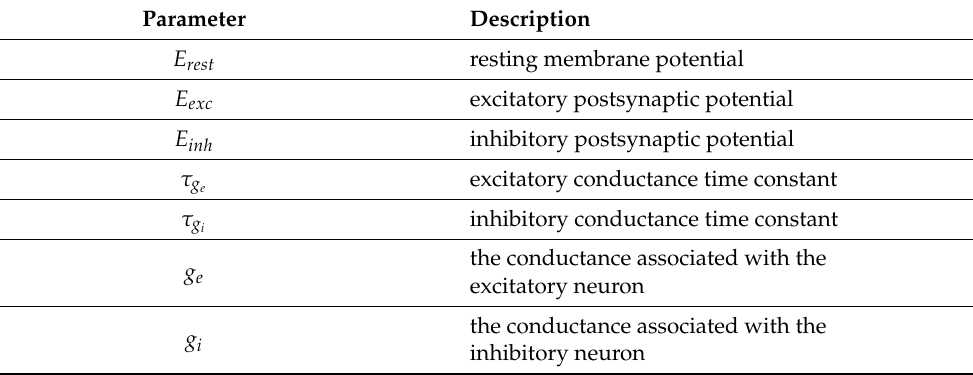
Table 1. Parameter descriptions in the neuron